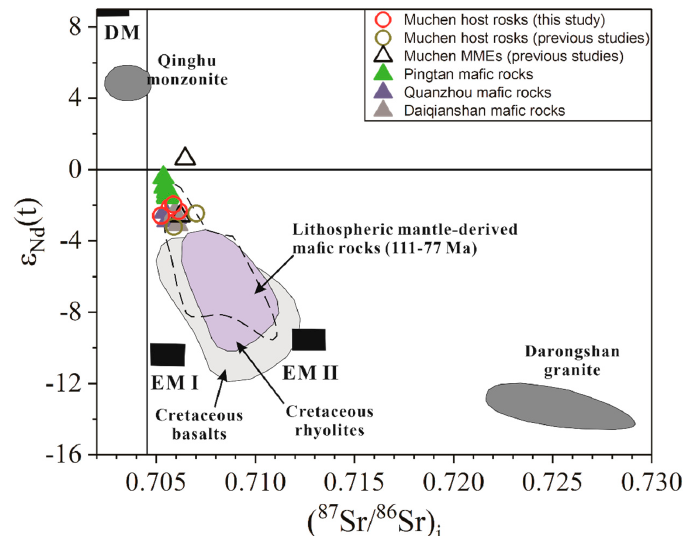
Figure 10. ( 87 Sr/ 86 Sr) i versus ε Nd ( t ) diagram for Muchen rocks. Data source: Previous data of Muchen